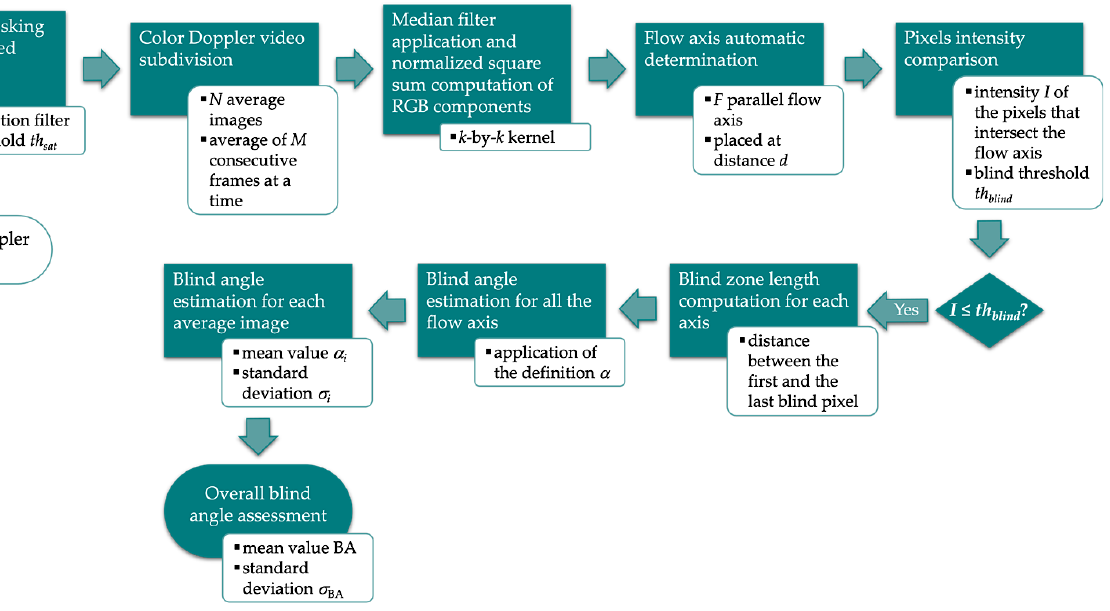
Figure 1. Flow chart of the image analysis-based method for blind angle parameter estimation.